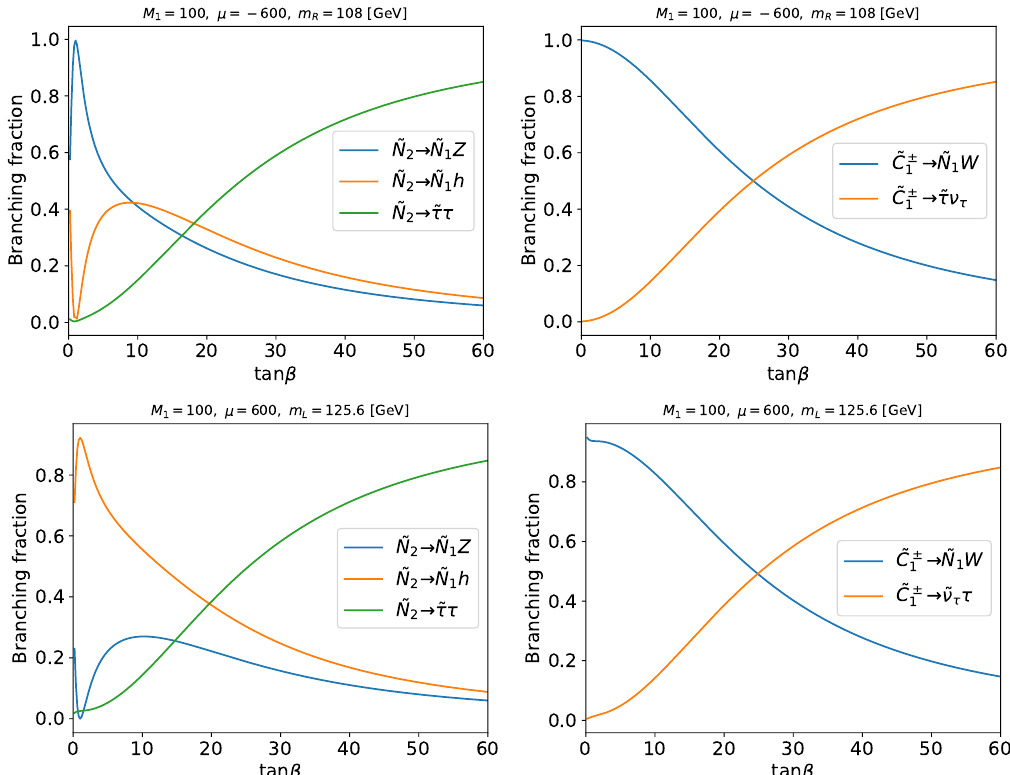
Figure 2 . Branching fractions of the higgsino-like neutralino and chargino. The top left (right) panel shows the branching fractions of ~ N 2 ( ~ C (cid:6) ) in the BHR scenario, while the bottom left (right) 1 panel shows the branching fractions of ~ N 2 ( ~ C (cid:6) ) in the BHL scenario. Relevant parameters are 1 shown in each (cid:12)gure, and others are taken to be larger than 3